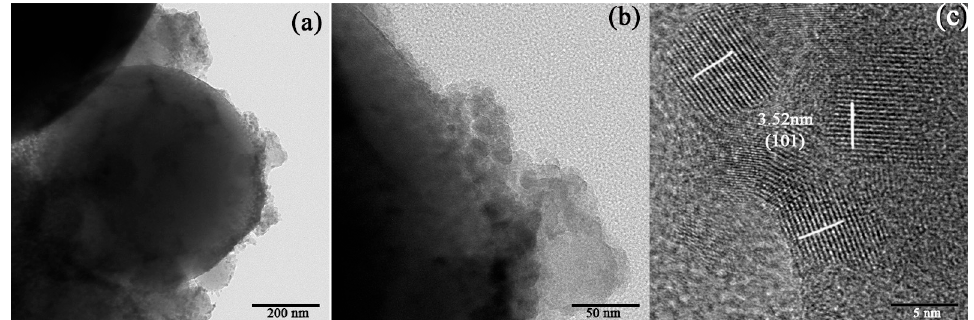
Figure 8. ( a , b ) Transmission electron microscope (TEM) and ( c ) high resolution transmission electron microscopy (HRTEM) images of SiO 2 –TiO 2 at different scales.